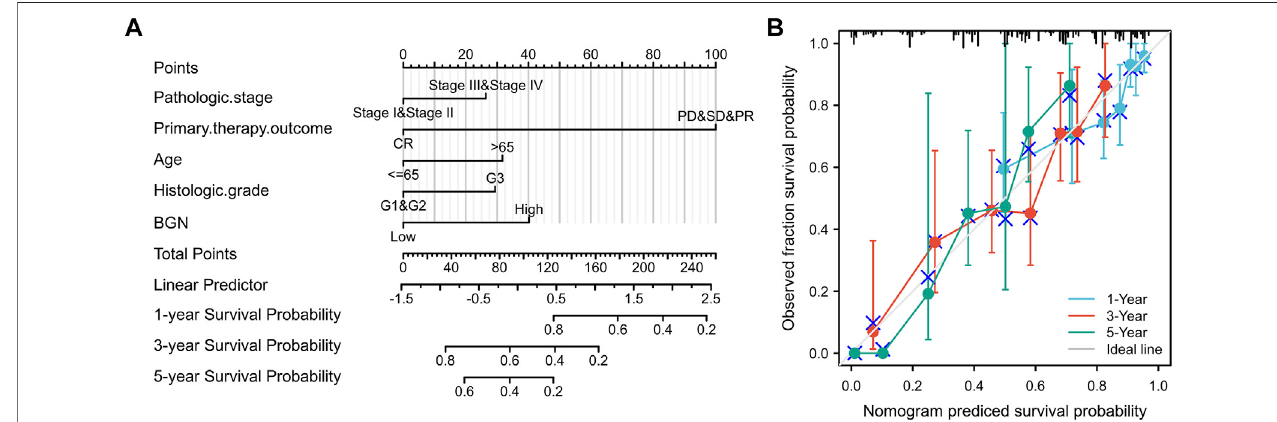
FIGURE 5 | Association with BGN expression and clinicopathological characteristics. (A) Histologic grade, (B) Histological type, (C) Pathologic stage, (D) T stage (E) Nstage, (F) Mstage, (G) Hpylori infection, (H) Residualtumor, (I) Gender, (J) Age, (K) Primarytherapyoutcome,and (L) BarrettsesophagealinGCpatientsinTCGA cohort. TCGA, The Cancer Genome Atlas; GC, gastric